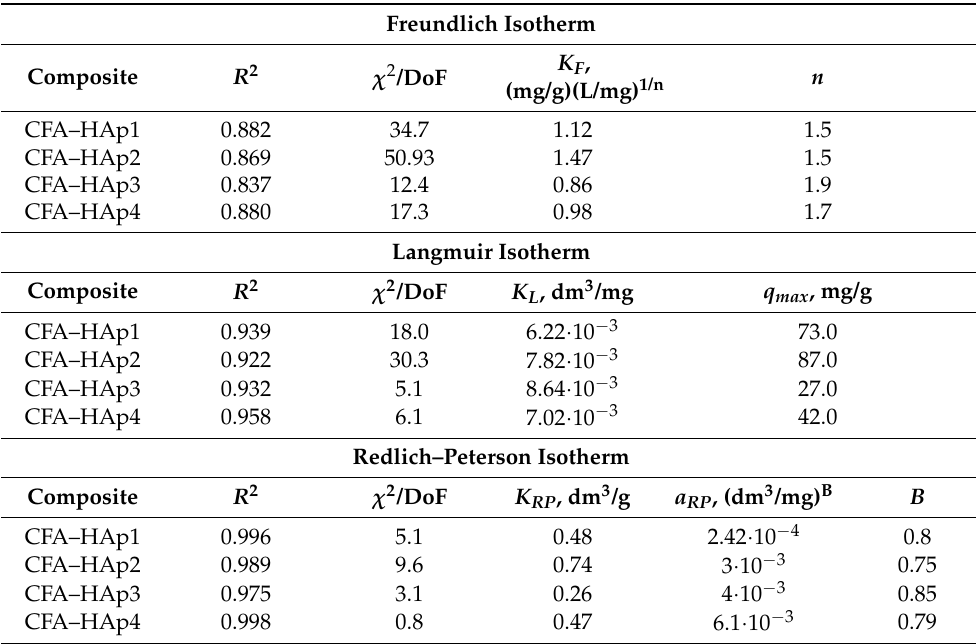
Table 5. Parameters of the isotherm models of RB adsorption on the CFA–HAp composites. Freundlich